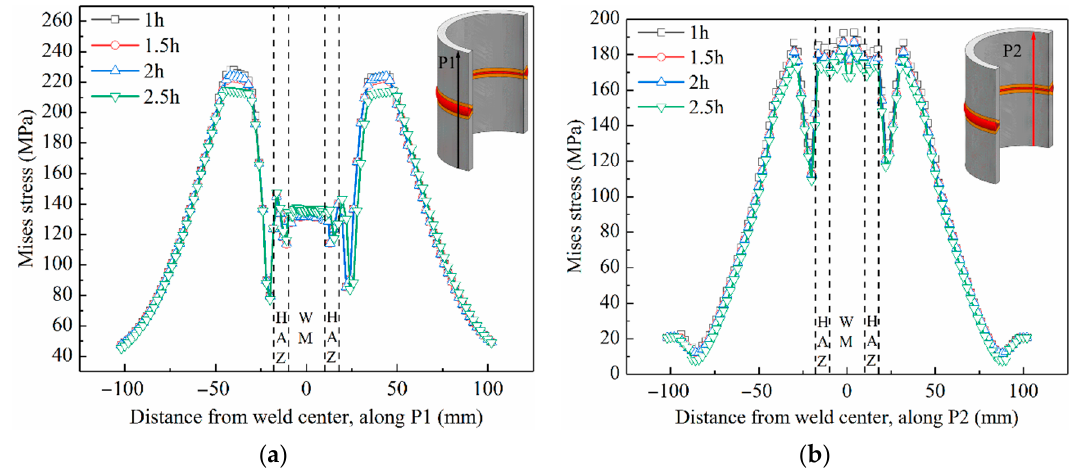
Figure 13. Mises stress distributions at different peak temperature along P1 path ( a ) and P2 path ( b ).